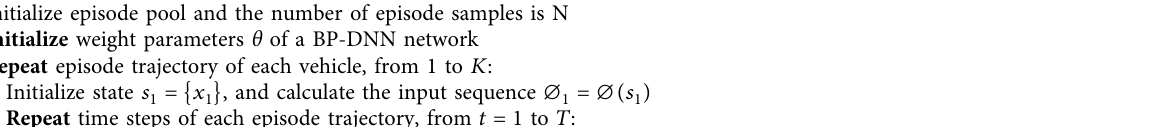
Table 4: Flowchart of BP-DNN estimator for fitting value function V ( s ) . Initialize episode pool and the number of episode samples is